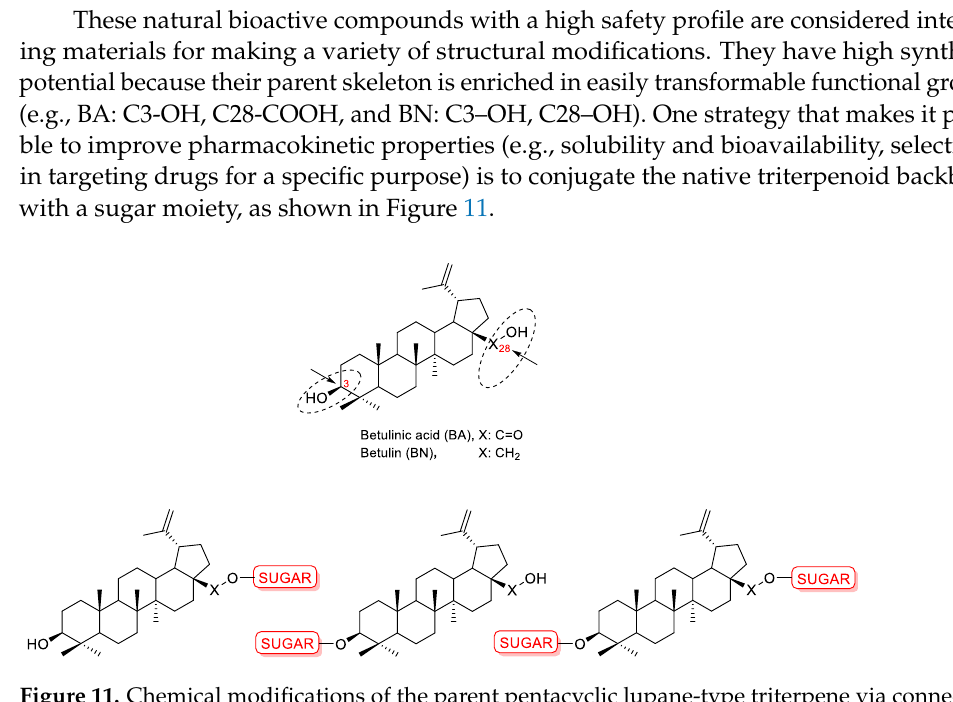
Figure 11. Chemical modifications of the parent pentacyclic lupane-type triterpene via connection with the sugar moiety at position C-28 and/or C-3 position.